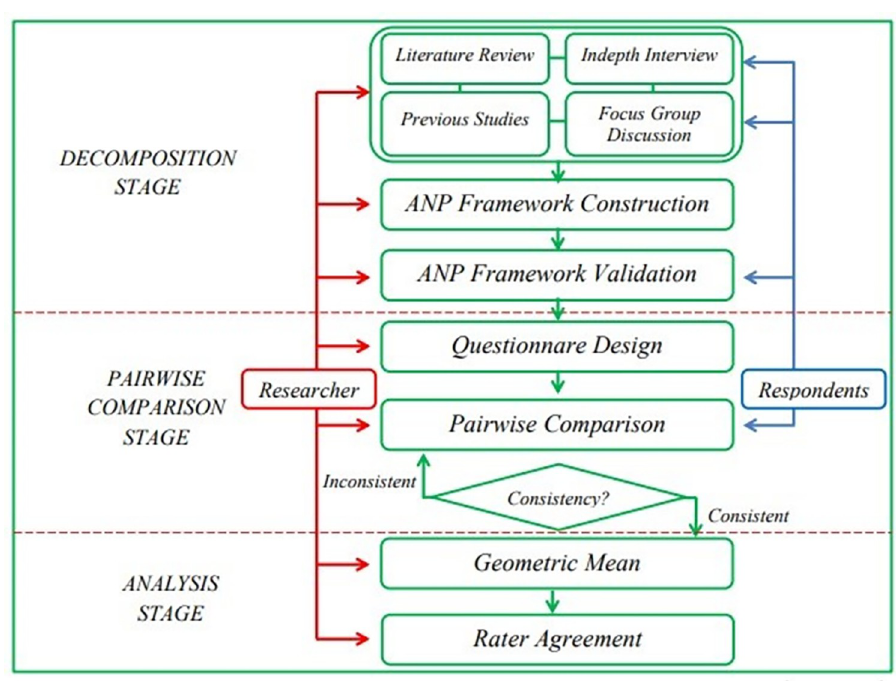
Fig 1. ANP BOCR research